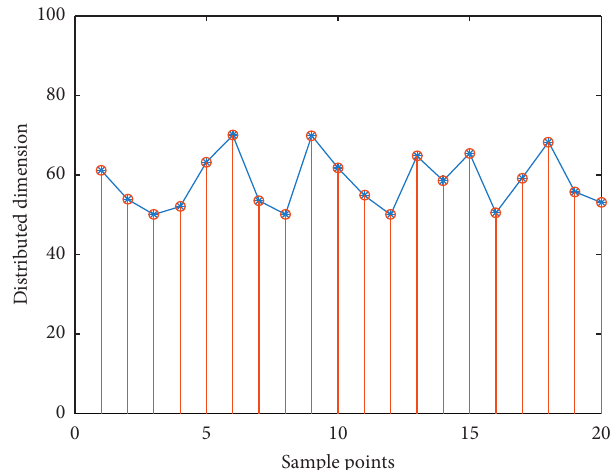
Figure 6: Dimension statistics of image